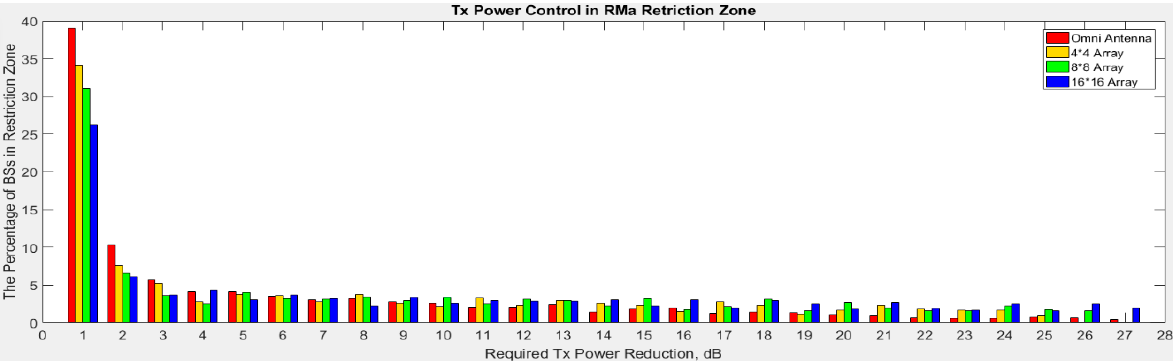
Figure 27. Tx power control chart in the RMa restriction zone.